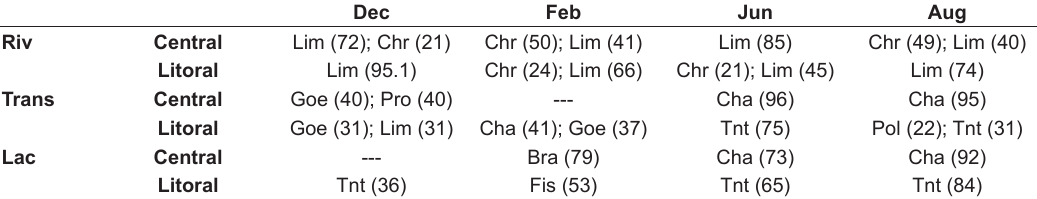
Figure 7. Density values (ind.m –2 ) referring to the benthic macroinvertebrates sampled at Itupararanga Reservoir, High Sorocaba Basin, SP, Brazil, during the wet season (December, 2009 and February, 2010) and during the dry season (June and August, 2010) in the riverine, transitional and lacustrine zones as also in central and littoral regions. *Res represents the average value considering the complete reservoir during the season. Table 5. Predominant taxons (>20%) from each sampling considering riverine (Riv), transitional (Trans) and lacus- trine (Lac) zones; central and littoral regions and month when them were sampled (December, 2009; Frebruary, June or August, 2010). The taxons are L. hoffmeisteri (Lim); Chironomus sp (Chr); Goeldichironomus sp (Goe); Procladius sp (Pro); Chaoborus sp (Cha); Tanitarsini (Tnt); Polypedilum sp (Pol); B. sowerbyi (Bra) and Fissimentum sp